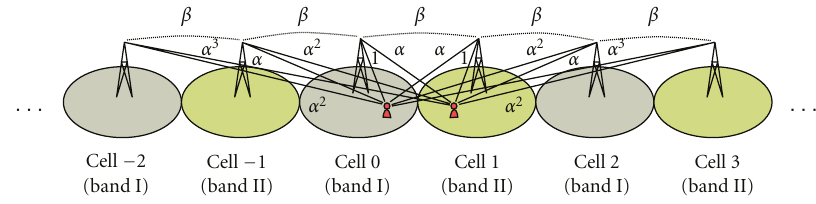
Figure 1: Cellular system layout (Wyner